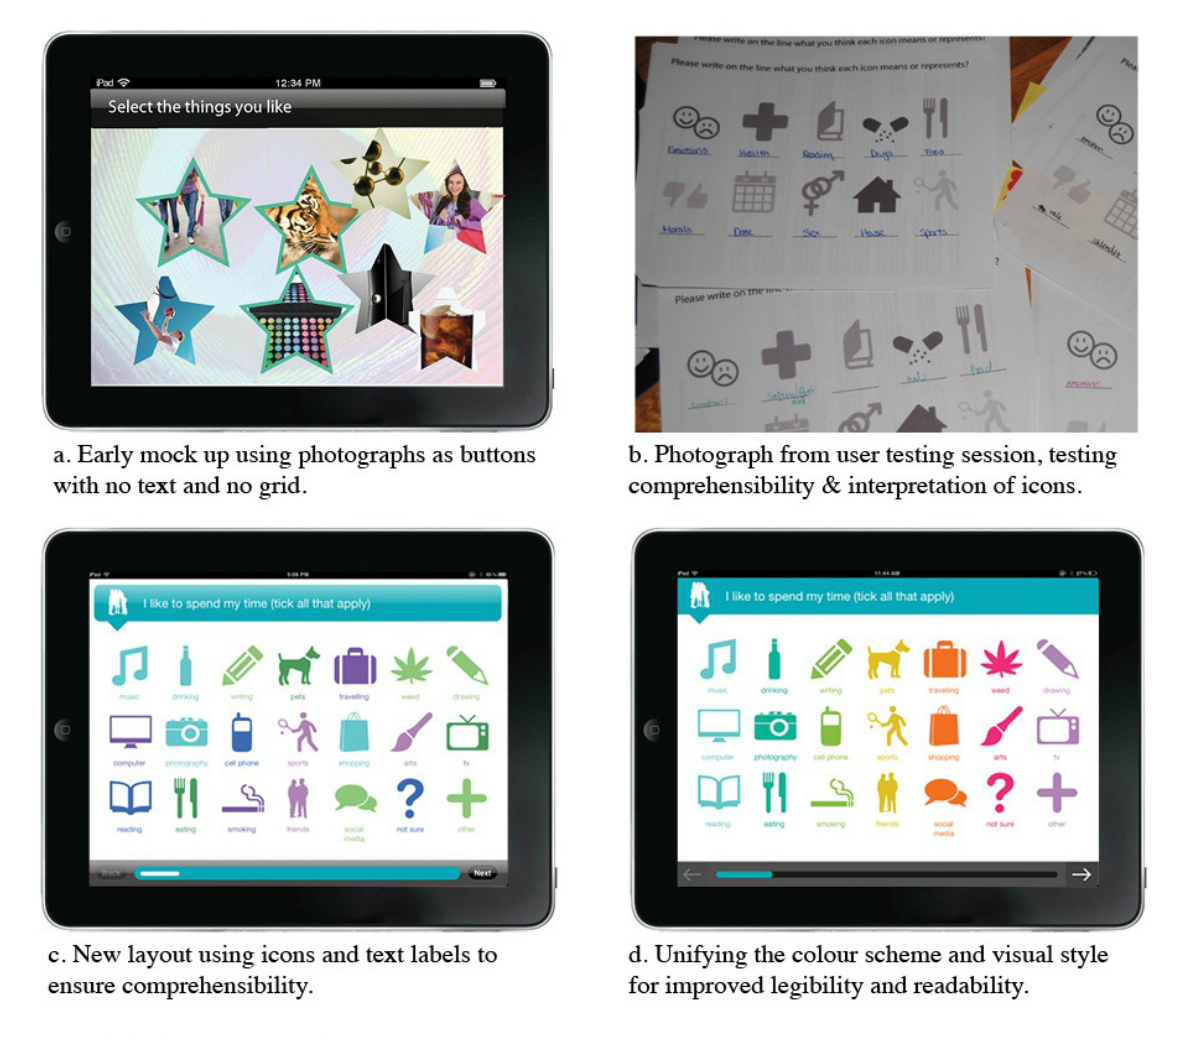
Figure 2. The Co-Creation